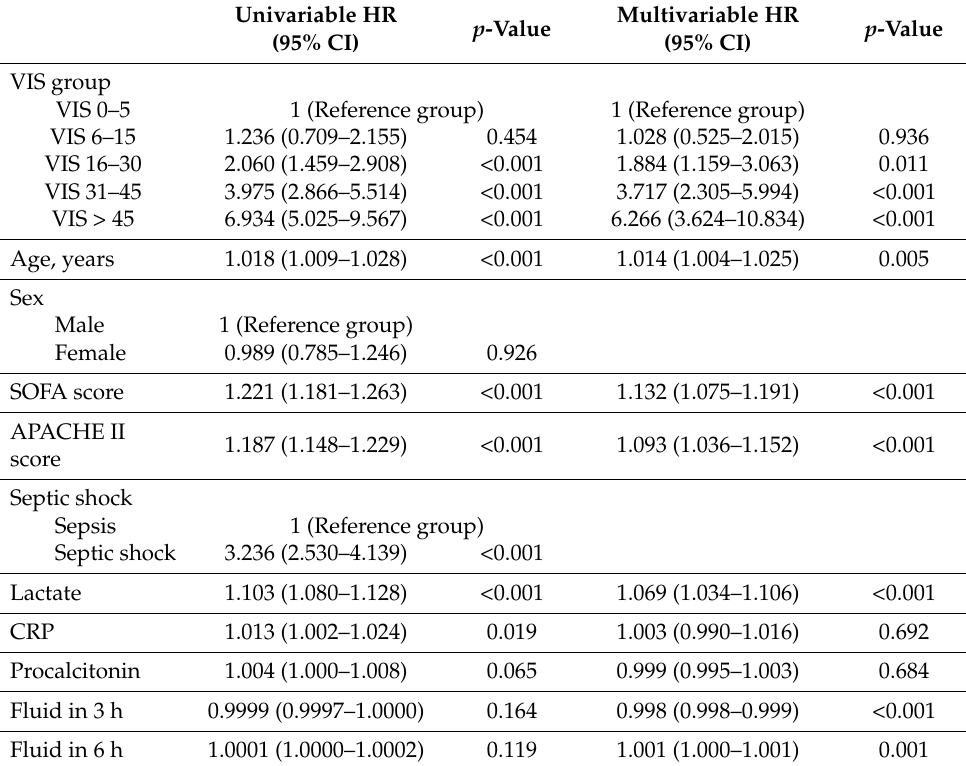
Table 4. Predictors of 30-day mortality using the Cox proportional hazards